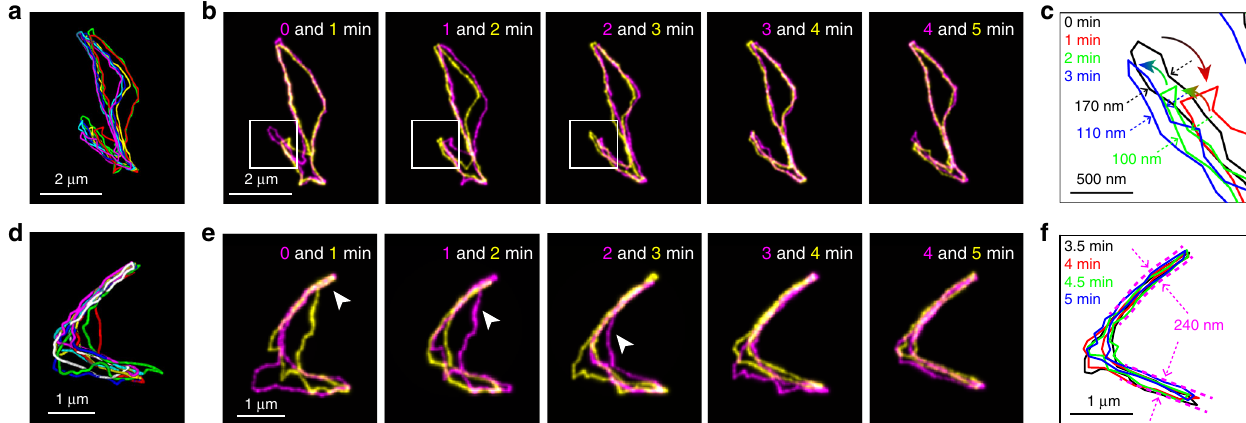
Fig. 7 Diverse conformation and motion of the entangled cyclic DNA molecules. a Superimposed 3D contours of the Cy5-labelled Charomid 9-42 DNA in an aqueous solution containing 7 mg ml − 1 concentration of non-labelled lambda DNA. b 2D projected contours of the DNA molecule displayed in a . The local widths of the contours correspond to the standard deviations of the Gaussian at each local segment. Two contours obtained from adjacent time frames are shown in each panel in cyan (earlier time points) and yellow (later time points). An enlarged view of the areas highlighted by the squares is shown in c . c Enlarged view of the highlighted region in b . d Superimposed 3D contours of the Cy5-labelled Charomid 9-42 DNA in an aqueous solution containing 5 mg ml − 1 concentration of non-labelled lambda DNA. e 2D projected contours of the DNA molecule displayed in d . The local widths of the contours correspond to the standard deviations of the Gaussian at each local segment. Two contours obtained from adjacent time frames are shown in each panel in cyan (earlier time points) and yellow (later time points). f 2D projected contours of the DNA molecule displayed in d obtained between 3.5 and 5 min. The dashed lines show virtual tubes with a diameter of 260